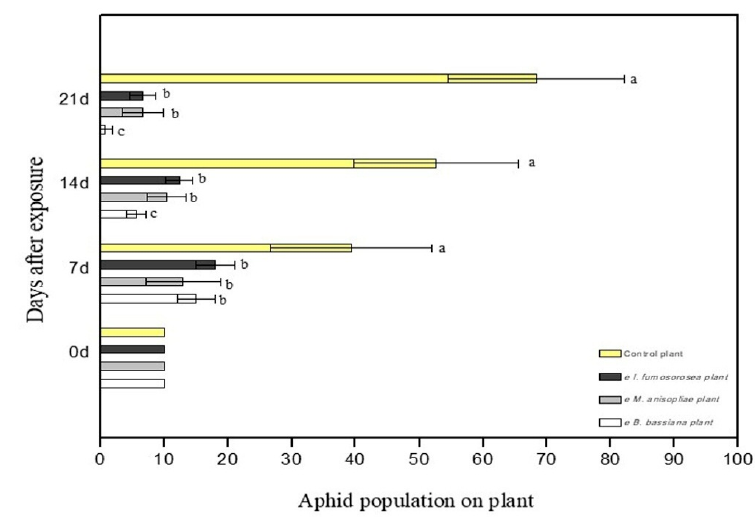
Figure 4. M. persicae aphid population on the leaves of C. annum plants after exposure to endophytic entomopathogenic fungi. Mean ± sd values with the same superscript letter are not different in a significant way. (Bonferroni’s test: p <0.05). Table1. Proportionterminating, proportionsurviving, cumulativeproportionsurviving andhazard rate of endophytic colonized pepper plants on young apterous adults of the M. persicae aphid (Kaplan–Meier survival function, life table